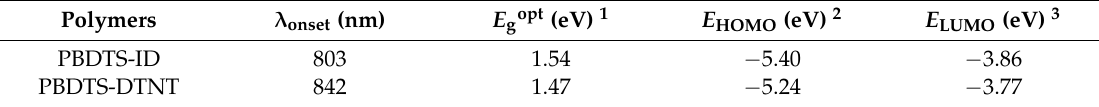
Table 1. Optical and electrochemical properties of the polymers.